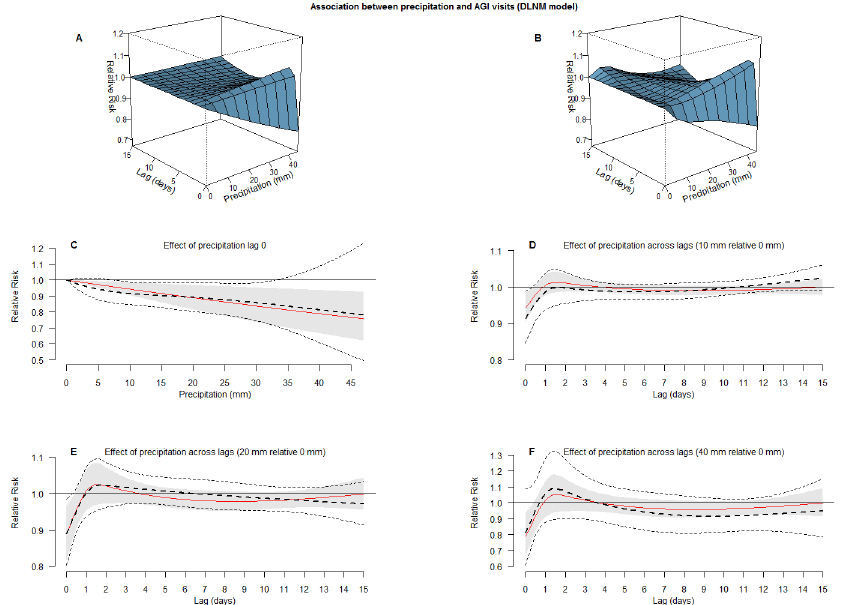
Fig 2. Association between precipitation and AGI visits. Precipitation effects on daily number of AGI visits (AWU area) produced from two DLNM models, linear (shaded) and non-linear (dotted lines) in space of precipitation. A. 3-D surface illustrating linear effects of precipitation along lags. B. 3-D surface illustrating non-linear effects of precipitation along lags. C. Effect of precipitation at lag 0 with 95% confidence intervals. D. Effect of 10 mm precipitation along 0 – 15 lags with 95% confidence intervals. E. Effect of 20 mm precipitation along 0 – 15 lags with 95% confidence intervals. F. Effect of 40 mm precipitation along 0 – 15 lags with 95% confidence intervals.